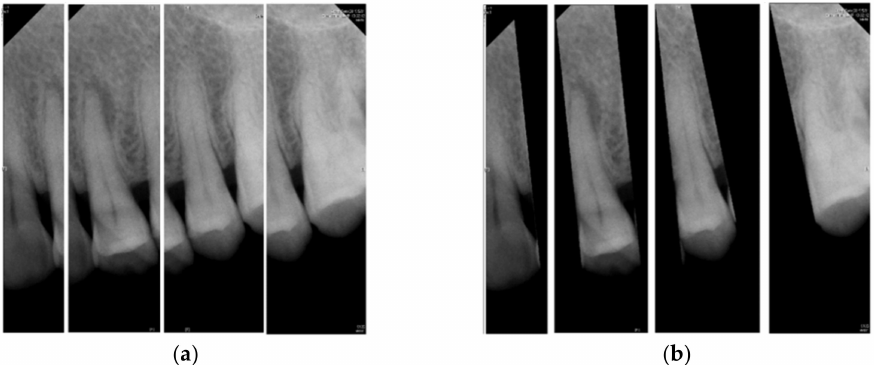
Figure 4. The results of the masking image. ( a ) original segmented, ( b ) retouched